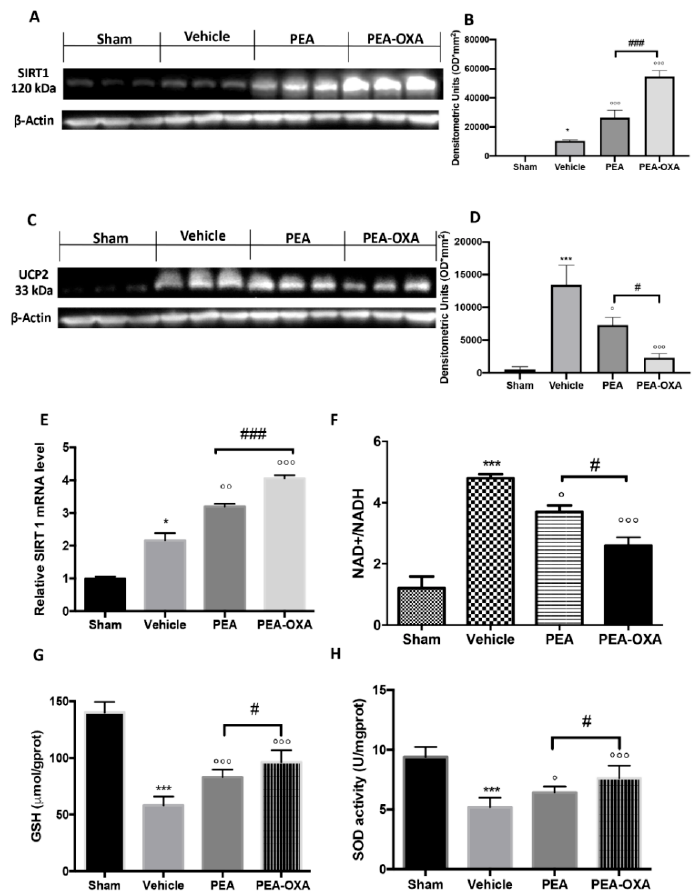
Figure 3. The efficacy of PEA-OXA on SIRT1 and UCP2 expression, the NAD + /NADH ratio, GSH, and SOD activity (induced by transient MCAo). A western blot analysis of SIRT1 showed basal expression that was significantly increased after MCAo. After PEA-OXA treatment, this expression was significantly upregulated, while after PEA administration, it increased less ( A , B ). Real-time PCR analysis of the SIRT1 gene displayed the same trend ( E ). UCP2 expression in vehicle-treated animals was significantly increased compared to the sham-operated animals. PEA-OXA administration was able to significantly restore the basal levels ( C , D ). PEA displayed less protection. The NAD + /NADH ratio was reduced by PEA-OXA treatment compared to the vehicle-treated animals ( E ). MCAo reduced GSH ( G ) and SOD ( H ) activity in vehicle-treated animals, while PEA-OXA administration restored the basal levels. A p -value of less than 0.05 was considered significant: * p < 0.05 versus sham; ° p < 0.05 versus vehicle; ** p < 0.01 versus sham; °° p < 0.01 versus vehicle; *** p < 0.001 versus sham; °°° p < 0.001 versus vehicle; # p < 0.05 versus PEA; ## p < 0.01 versus PEA; ### p < 0.001 versus PEA.